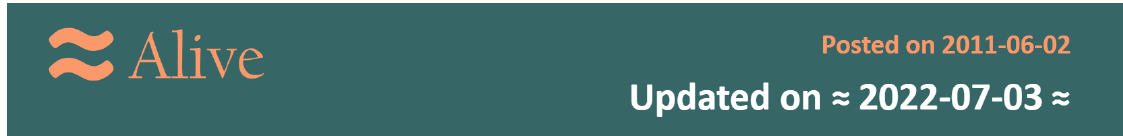
Figure 1. Banner of an alive publication. The date of the first placement and the date of the current (fresh) revision are indicated.